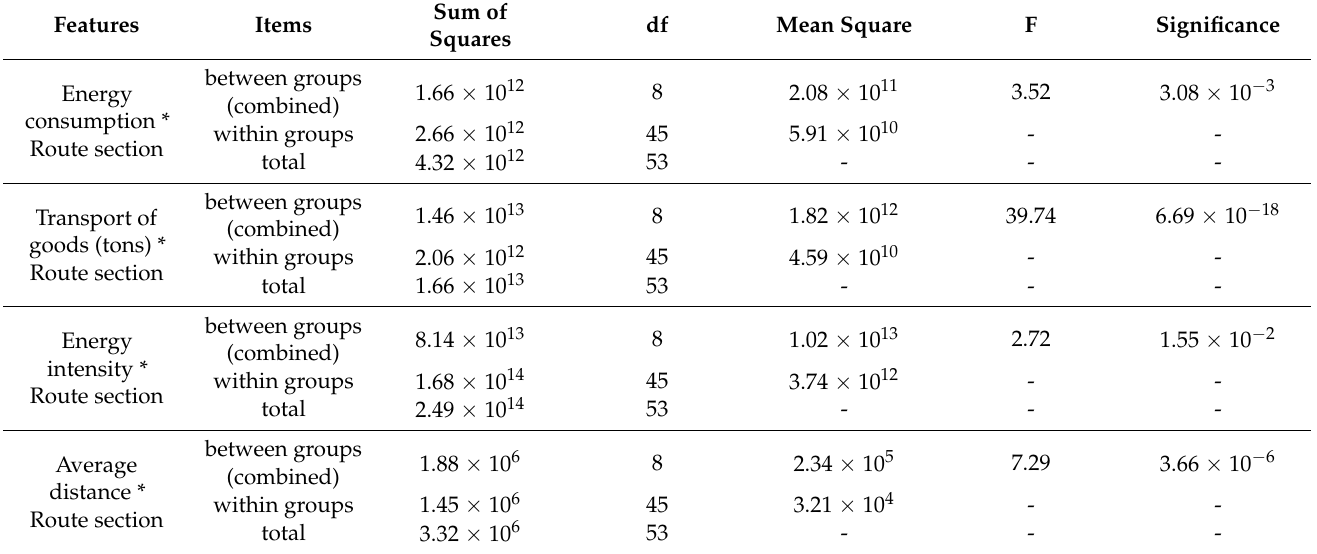
Table 5. Analysis of variance